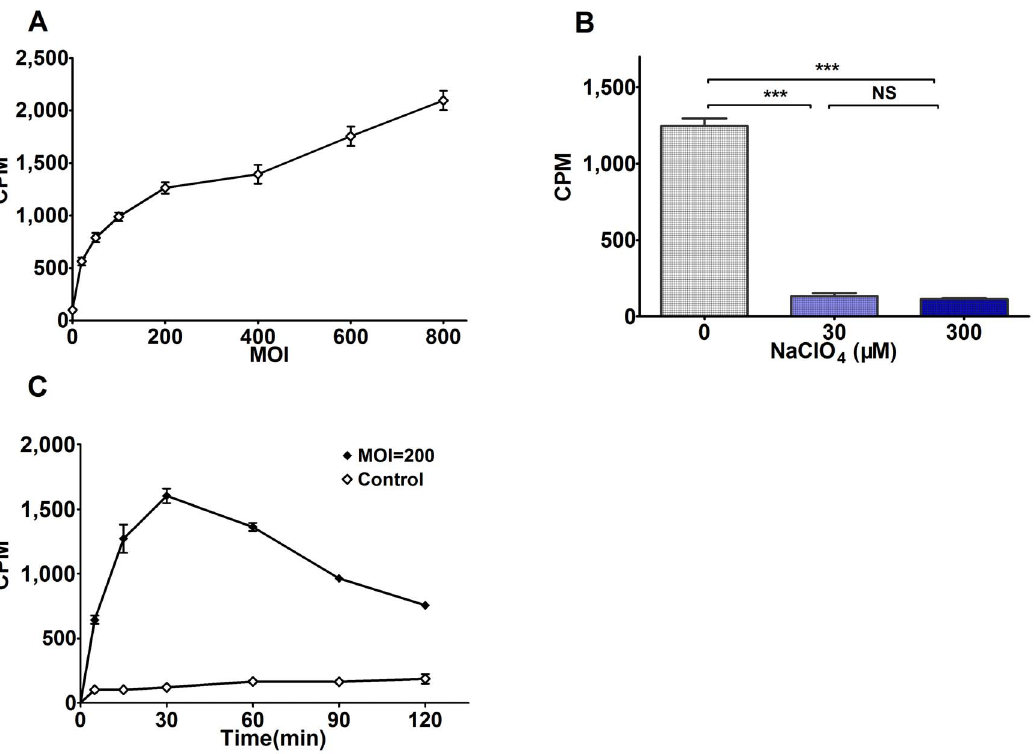
Bac-NIS-infected hUCB-MSCs at MOI=200. Results are means 6 SD (n=3). Abbreviations : cpm, counts per minute; ***, P , 0.001; NS, no statistically significant difference.